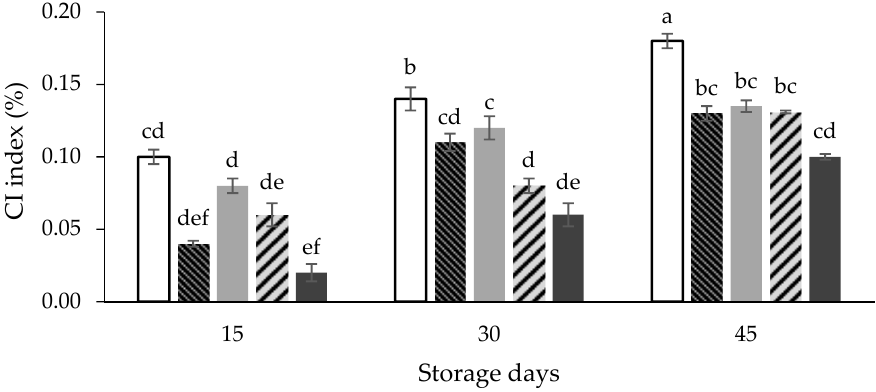
Figure 2. Effects of chitosan, phenylalanine, and chitosan-coated phenylalanine nanoparticles treatments on the chilling index of persimmon fruit during storage at 4 °C for 15, 30, and 45 days. Each value represents the mean ± standard errors of three replications. Different letters indicate statistical differences using Duncan’s multiple range tests at P < 0.05 level.